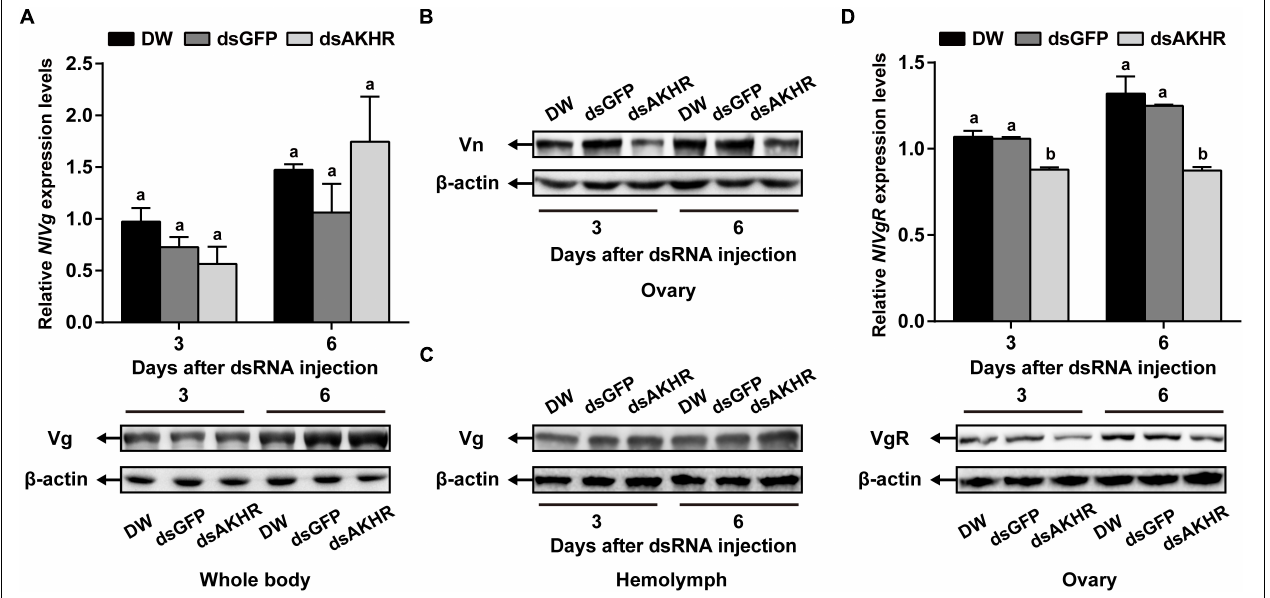
FIGURE 4 | Effects of NlAKHR knockdown on the Nl Vg biosynthesis and transportation. Newly emerged females were injected with DEPC-treated water (DW) or dsRNA for NlAKHR or GFP (control) genes. (A) NlVg mRNA levels and Nl Vg protein abundance in the whole body were determined on the 3rd and 6th day after dsRNA injection. (B) The amounts of vitellin (Vn) in the ovary (B) and Vg in the hemolymph (C) were determined by western blot on the 3rd and 6th day after injection. (D) The ovary was obtained on the 3rd and 6th day after dsRNA injection. NlVgR mRNA levels were detected by qPCR and Nl VgR protein amounts were determined by western blot. The results are represented as means ± SE from three independent experiments. Differences between cDNA levels were determined by qPCR and analyzed using one-way ANOVA followed by Duncan’s multiple comparison. Different lowercase letters above the columns represent significant difference at P <